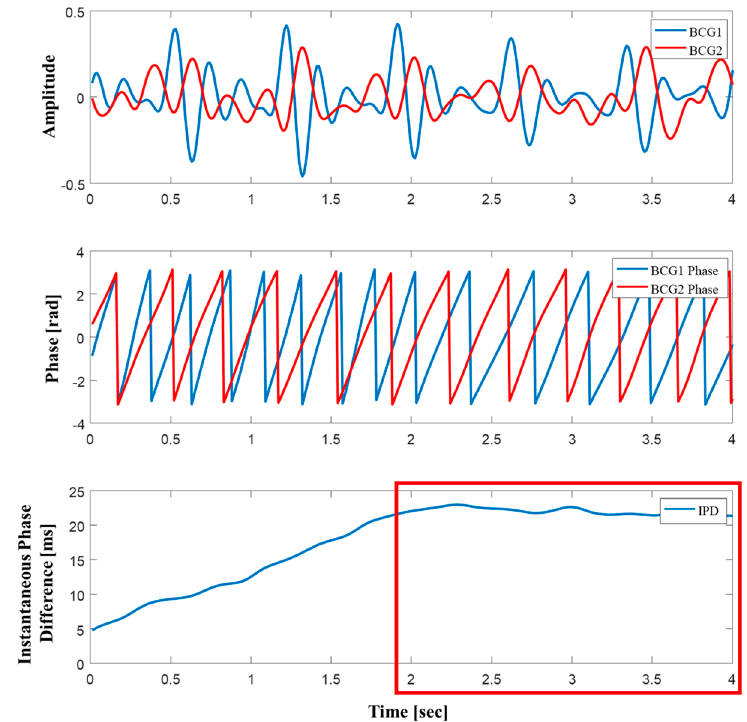
Figure 4. Process to calculate instantaneous phase difference (IPD).